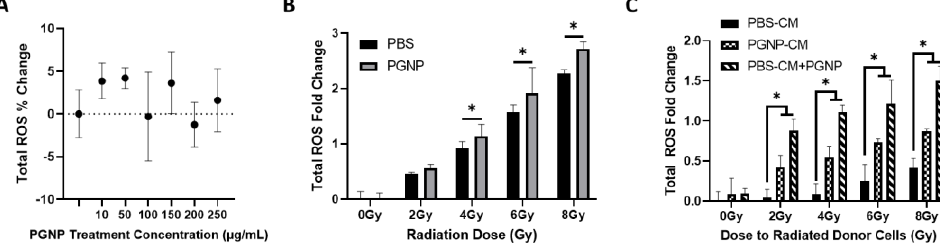
Figure 5. DCFDA total ROS production measurements normalized in accordance with the measurements of the untreated group. ( A ) Percentage of ROS change in LNCaP cells incubated with PGNPs under various concentrations. ( B ) Total ROS change induced by irradiation in LNCaP cells pretreated with and without 250 µg/mL PGNPs ( p < 0.05 at 4, 6, and 8 Gy). ( C ) Total ROS change in bystander LNCaP cells in the following groups: treated with PBS-CM, treated with PGNP-CM, and bystander cells incubated with PGNPs for 24 h and treated with PBS-CM (PBS-CM+PGNPs) ( p < 0.05 at 2, 4, 6, and 8 Gy). * Denotes p < 0.05 from Welch’s t-test.